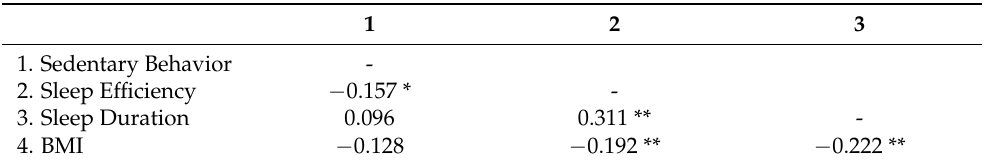
Table 2. Correlation analyses among study